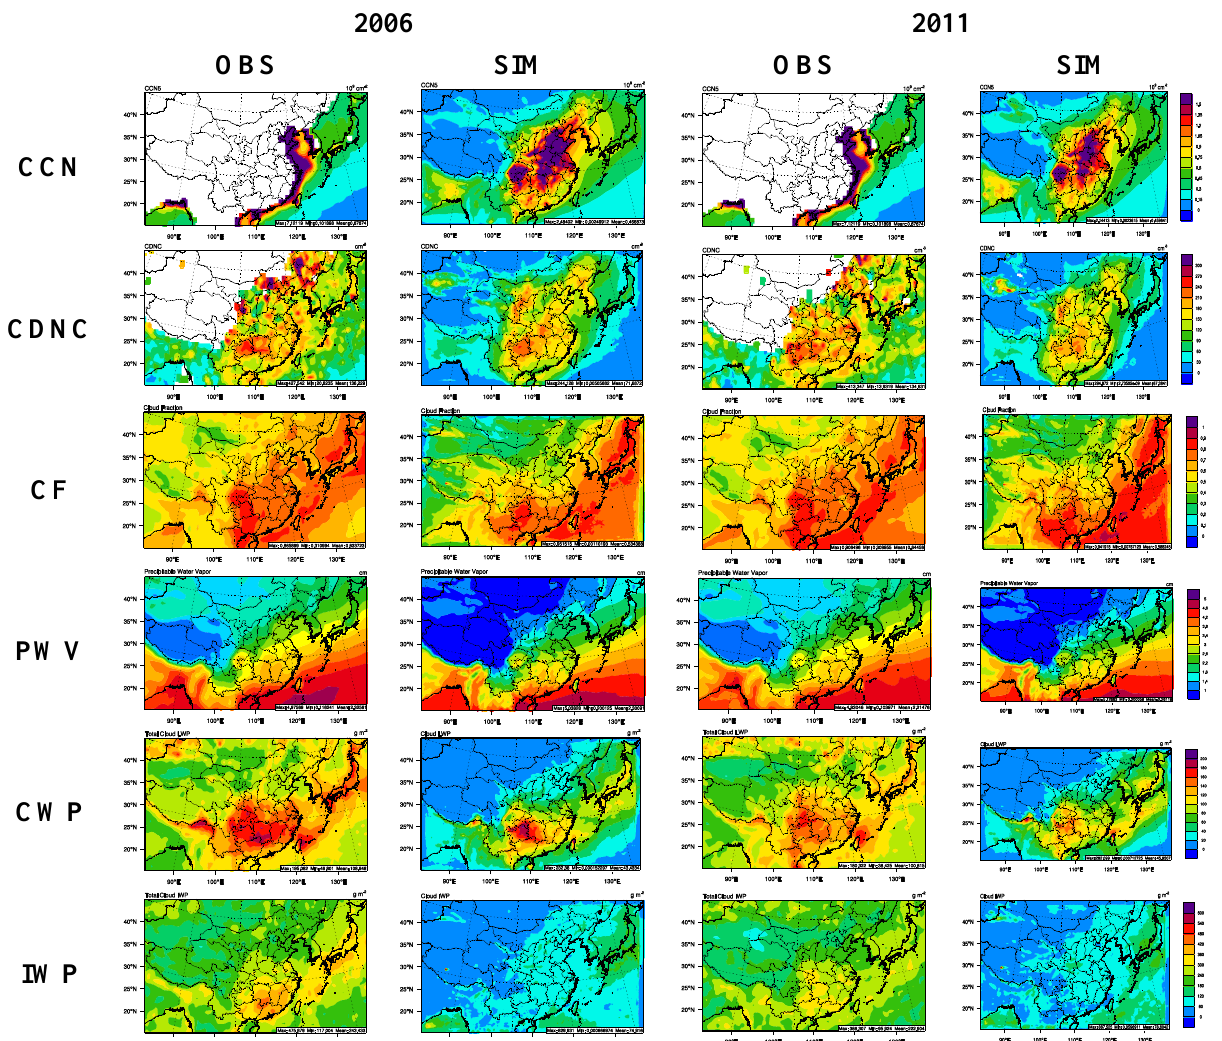
Figure 3. Spatial distributions of annual mean observed and simulated CCN, CDNC, CF, PWV, CWP, and IWP for the 2006 and 2011 simulations with